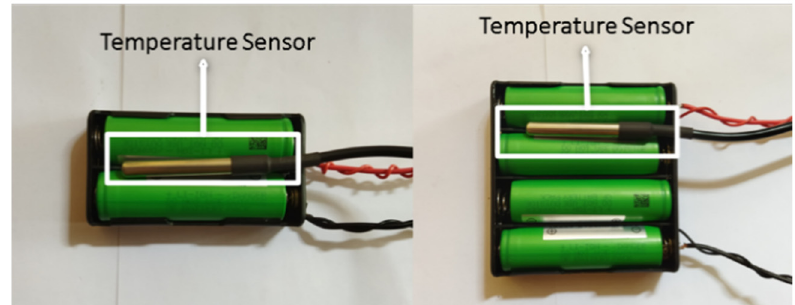
Figure 6. Battery temperature measurement.